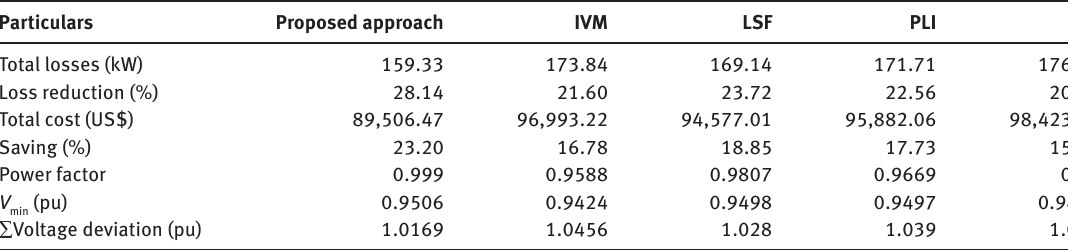
Table 9: Simulation Results Comparison among Various Approaches after SC Placement.